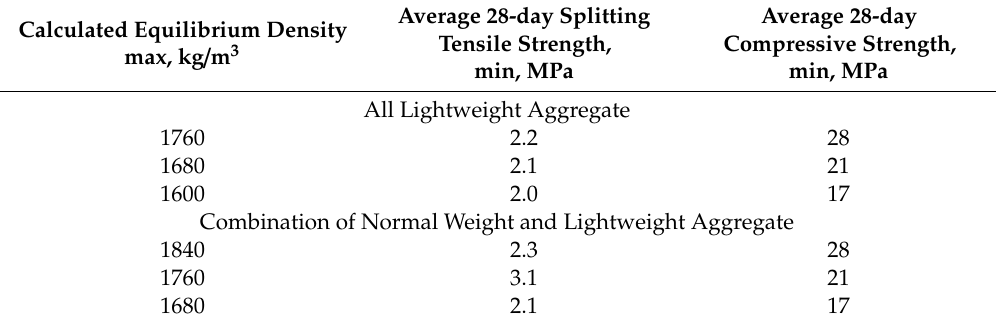
Table 1. Compressive strength and splitting tensile strength requirements for LWA [24]. Calculated Equilibrium Density max, kg / m